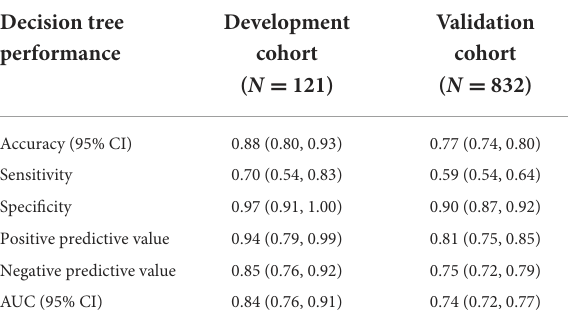
TABLE 2 Discrimination of the decision tree in the development and validation cohorts. Decision